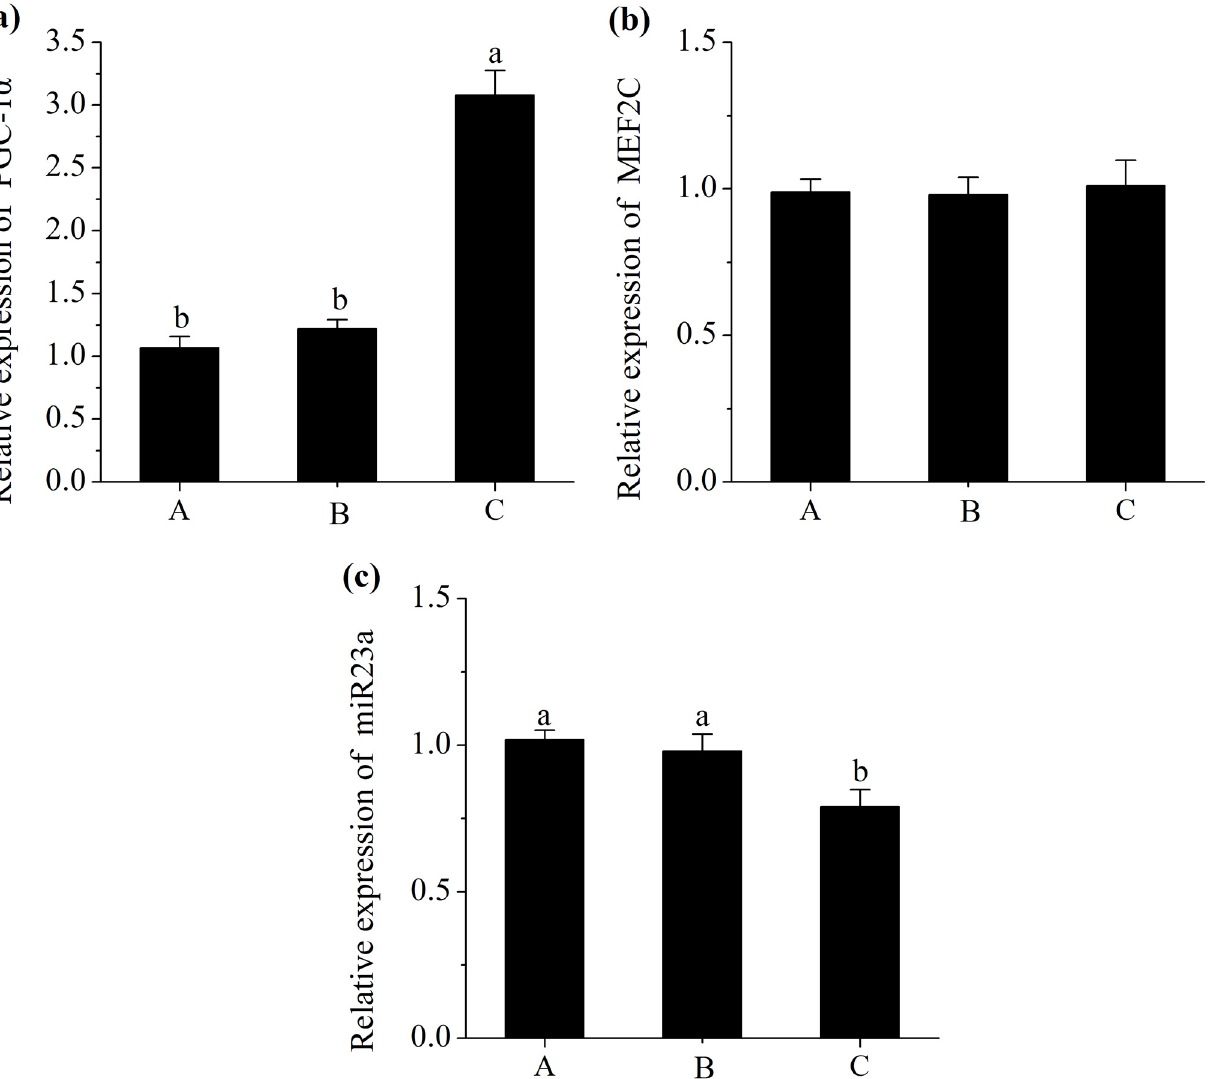
Fig 2. Relative mRNA expression of proliferator-activated receptor γ coactivator 1 α (PGC-1 α ) (a), Relative mRNA expression of myocyte enhancer factor 2C (MEF2C) (b) and Relative miRNA expression of miR23a (c). Diet A contained 44.1% starch, diet B contained 37.6% starch and diet C contained 30.9% starch. mRNA expressions were normalized to 18s rRNA gene expression. miRNA expression was normalized to UniSp6 expression. Data were shown as the mean ± standard error of eight replicates. a,b Mean values within different letters were significantly different ( P < 0.05).